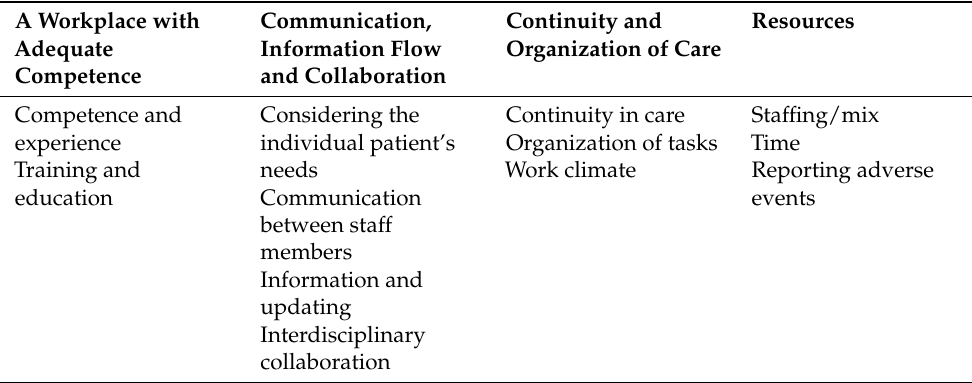
Table 2. Overview of main categories and